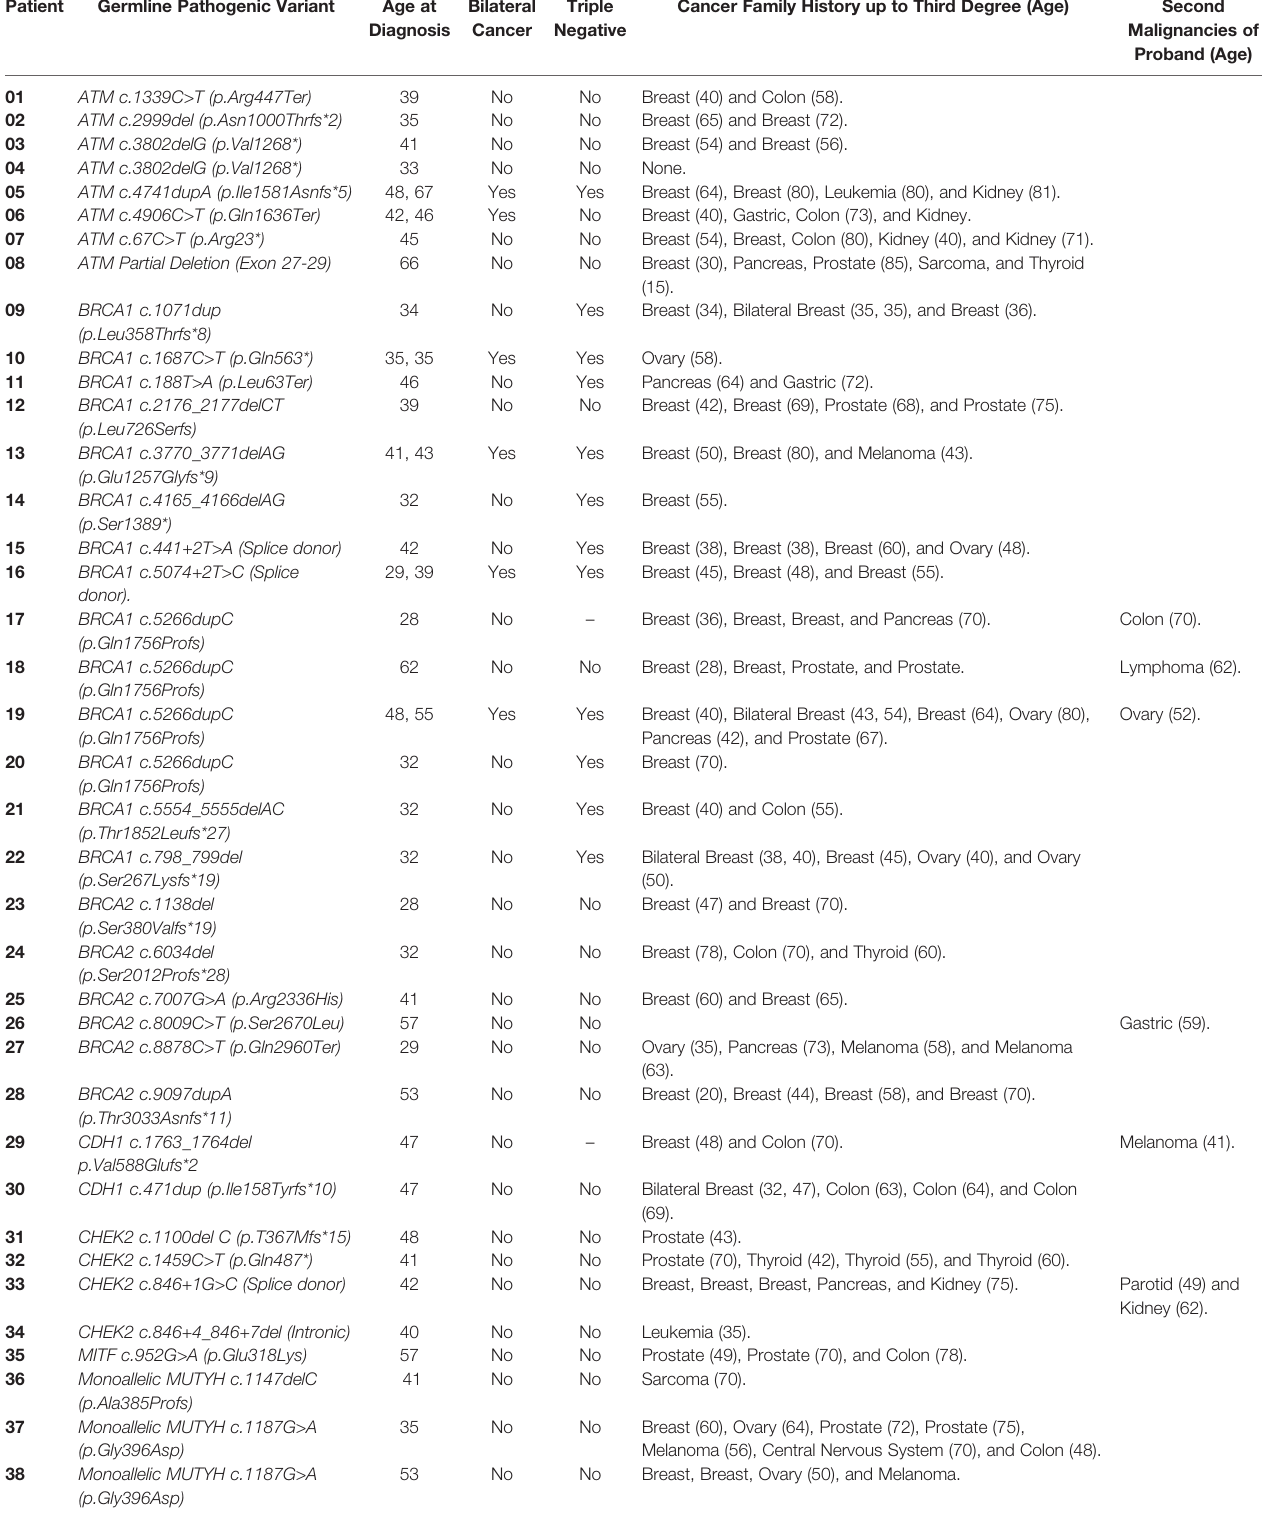
TABLE 4 | Description of germline pathogenic